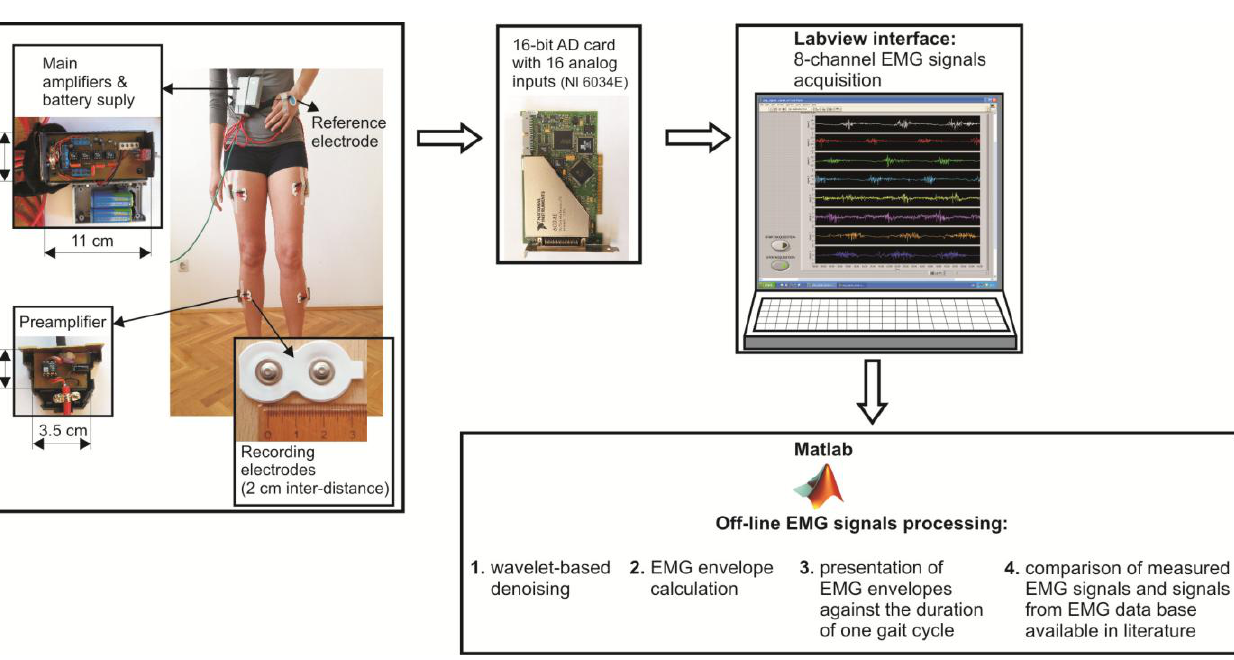
Figure 1. Flowchart of the prototype of surface electromyography (sEMG) system and EMG signal processing